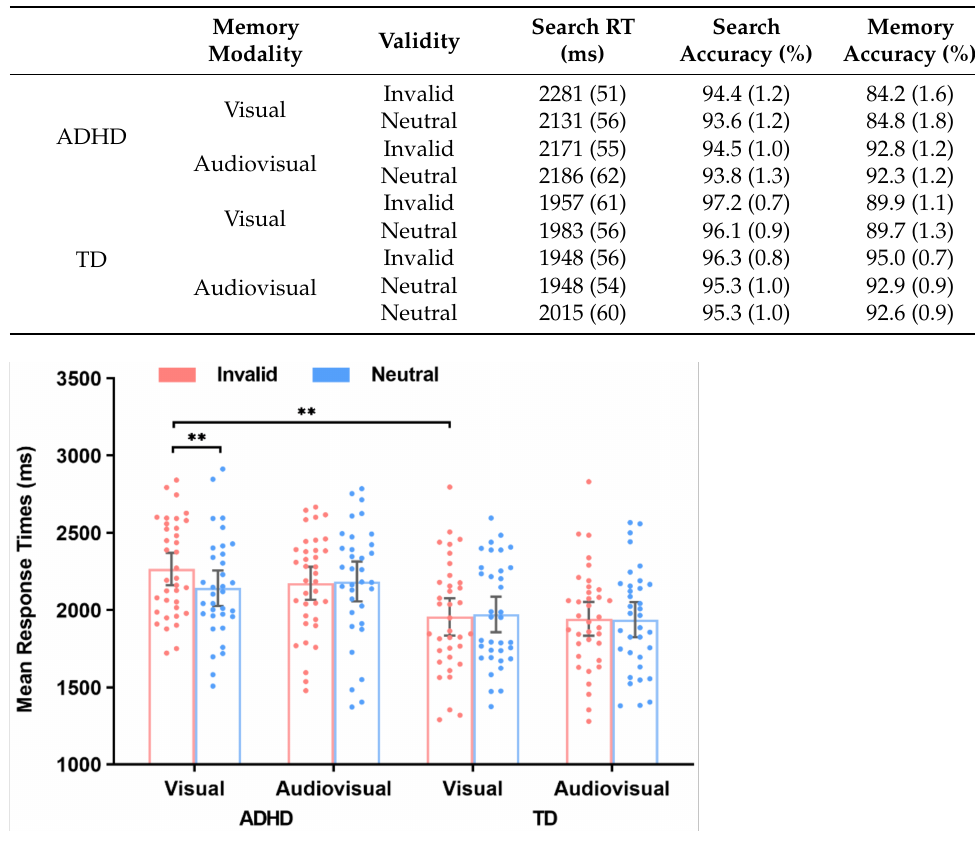
Figure 2. Mean response times for each condition (the mean response times are a function of memory modality, validity, and group). Error bars denote the within-subject 95% confidence intervals, as described by Morey (2008) [45]. ** p <